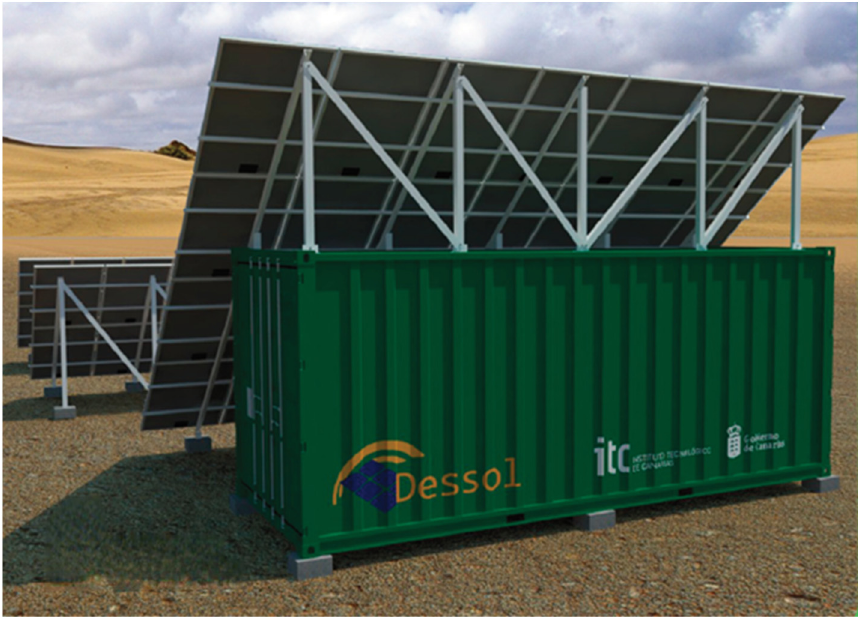
Figure 10. DESSOL+ desalination system (courtesy of the ITC).